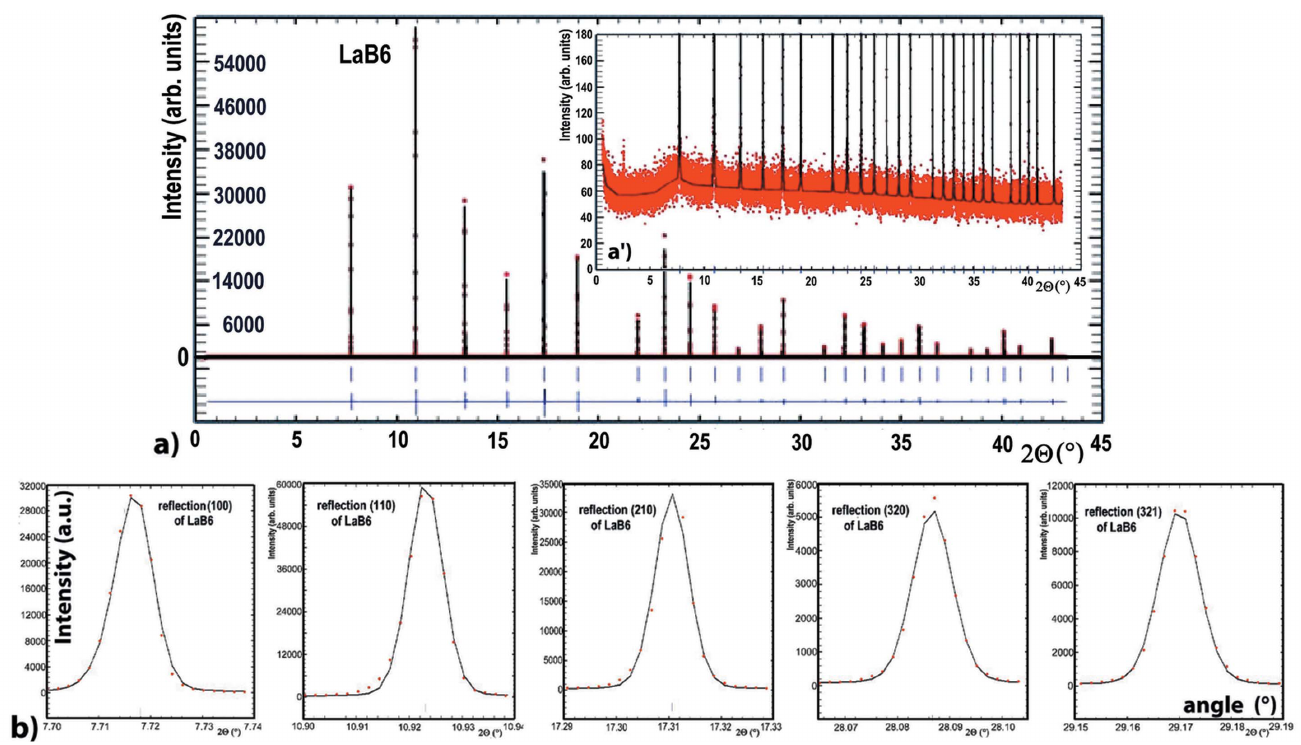
Figure 5 Diffraction pattern, and its Rietveld refinement, of an LaB 6 reference powder using data filtered by the single-crystal-comb + Soller-collimator + photon- counting detector setup. ( a , a 0 ) Intensity of the complete diffractogram using the sum of the beams filtered by the 20 Si(111) single-crystal blades, and magnification of this diagram which underlines the low residual background of this measurement. ( b ) Visualization of the good agreement between measured and calculated profiles of the (100), (110), (210), (320) and (321) reflections of LaB 6 ; their profiles are well described by a convolution of Gaussian and Lorentzian curves with FWHM = 0.008 (cid:2)